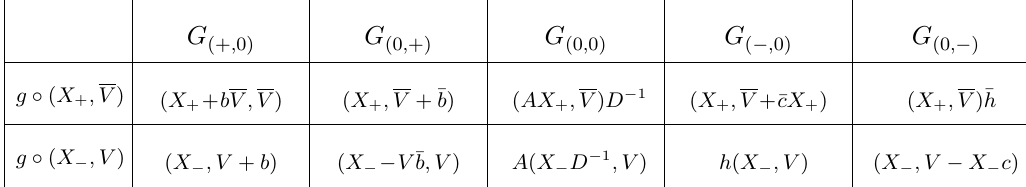
Table 1 . We used the de(cid:12)nitions h := ( 1 3 + V (cid:22) c ) (cid:0) 1 and (cid:22) h := ( 1 3 + cV ) (cid:0) 1 . The transformations corresponding to G , G are generated by the ones above. For convenience we give the (+ ; +) ( (cid:0) ; (cid:0) ) explicit form of special superconformal transformations G : ( X + ; V ) 7! ( X + ; V )(1 + CX + ) (cid:0) 1 ( (cid:0) ; (cid:0) ) and ( X (cid:0) ; V ) 7! (1 + X (cid:0) C ) (cid:0) 1 ( X (cid:0) ; V